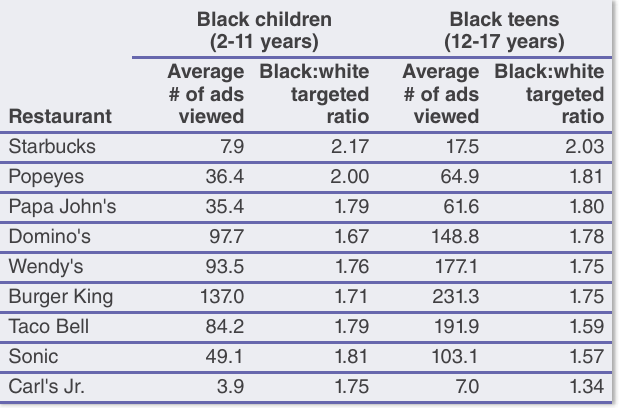
Table 41. Restaurants with the highest black:white targeted ratios Black